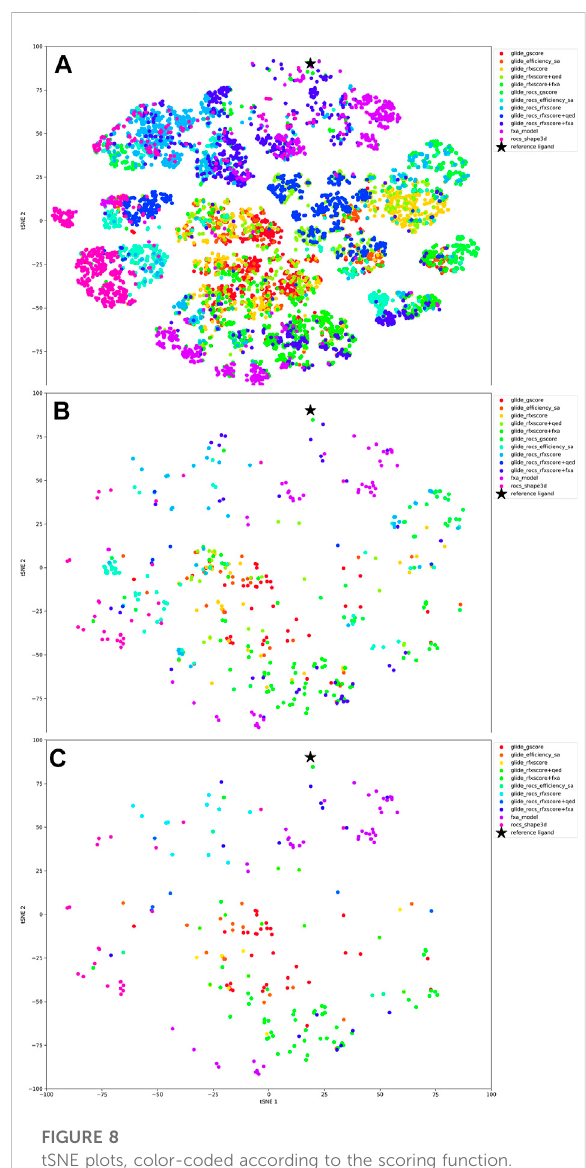
FIGURE 8 tSNE plots, color-coded according to the scoring